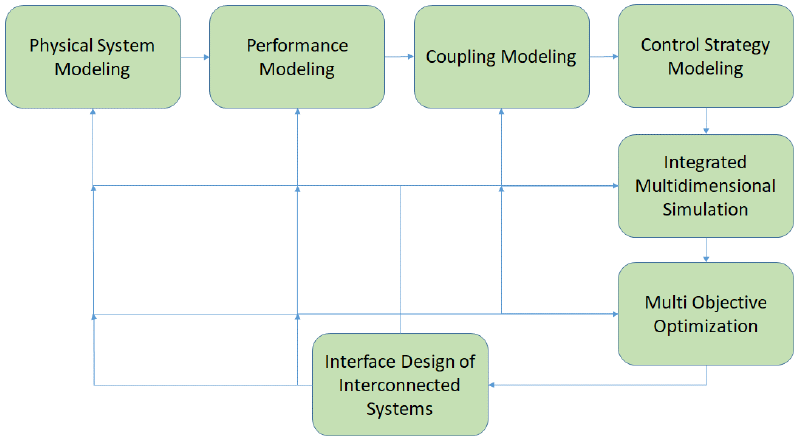
Figure 9. Engineering design of the unified interface of interconnected systems.